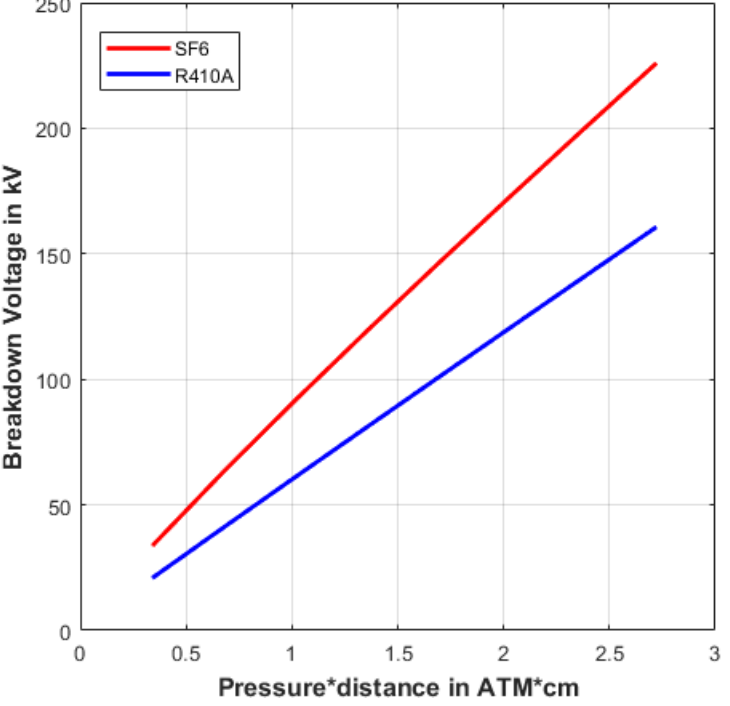
Figure 4. Theoretical Breakdown Voltage for R410A and SF6 as a Function of Pressure × distance.